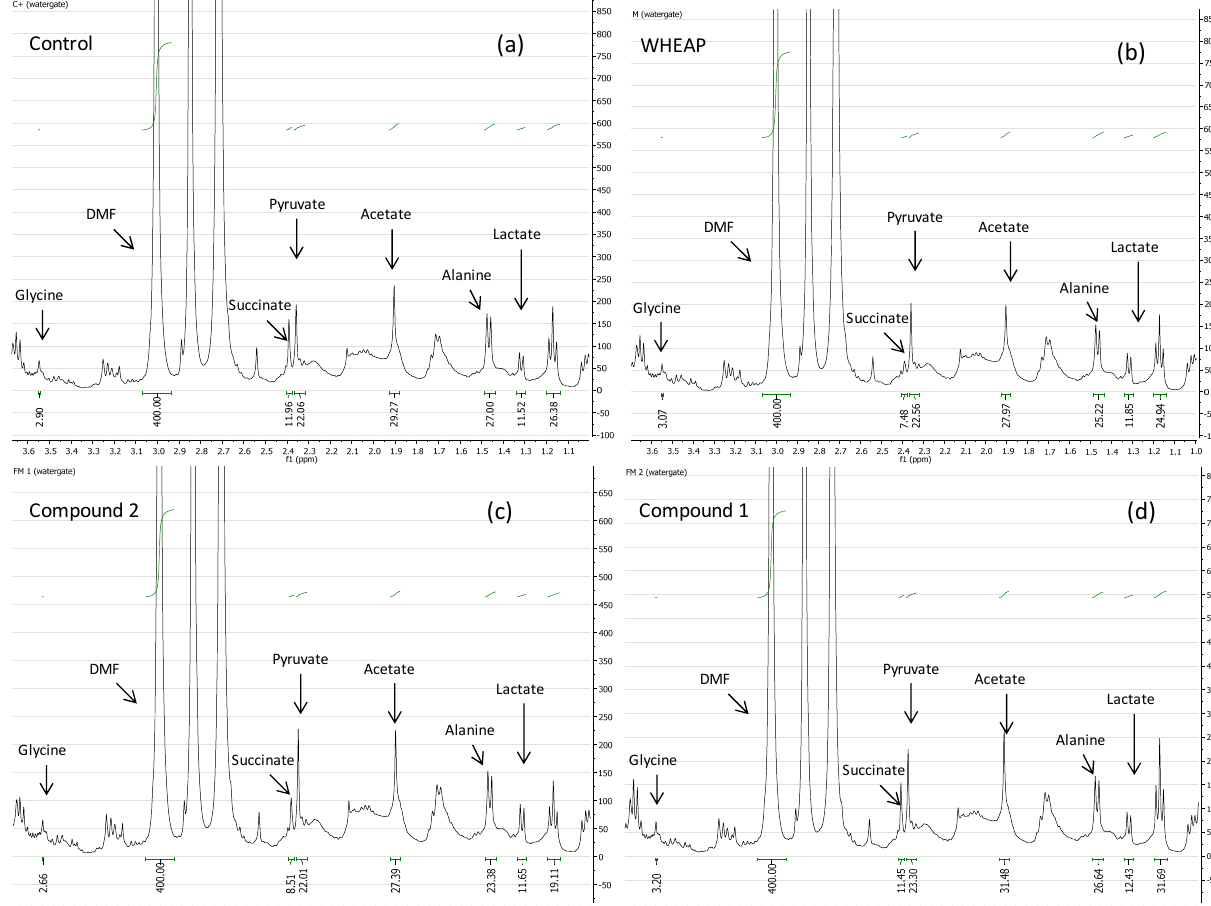
Figure 4. Examples of 1 H-NMR spectra of the cell-free milieu of: ( a ) untreated parasite “control”; ( b ) WHEAP-treated parasites; ( c ) compound 2- treated parasites; ( d ) compound 1- treated